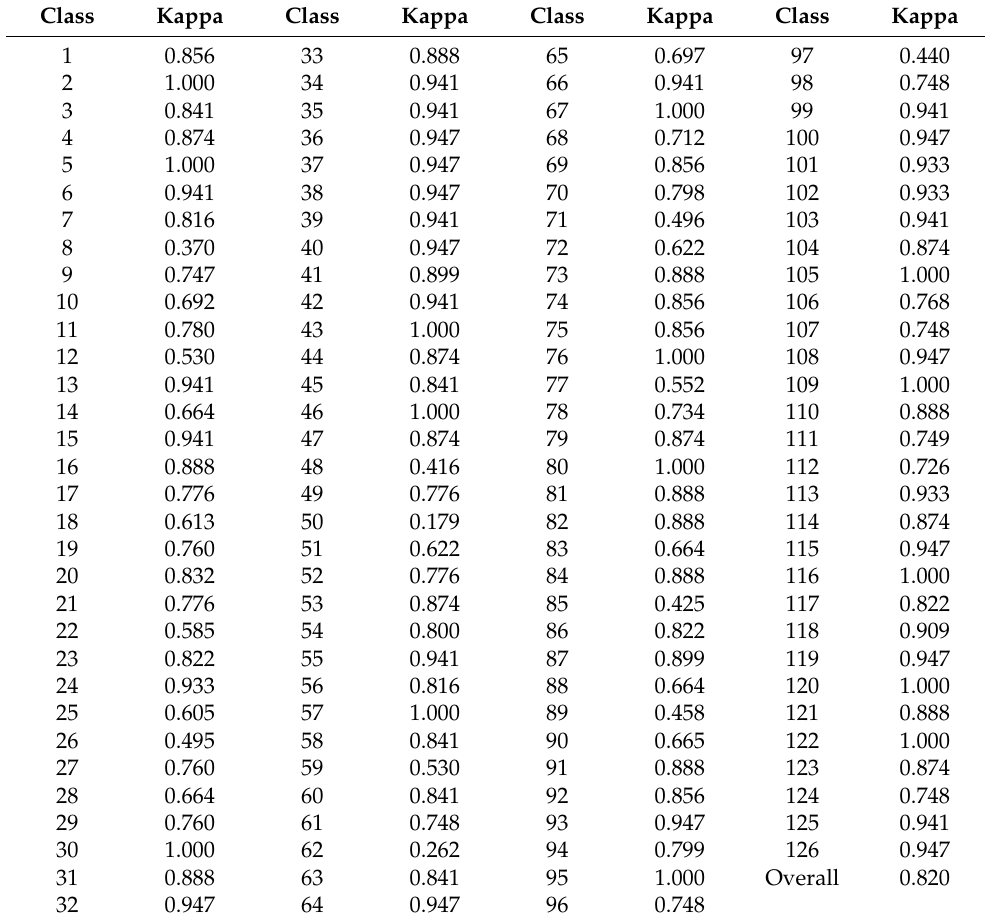
Table 4. Class-wise performance of dominant species level classification of plant communities. The numerical classes (1–126) correspond to the list of plant species enumerated and shown in Table